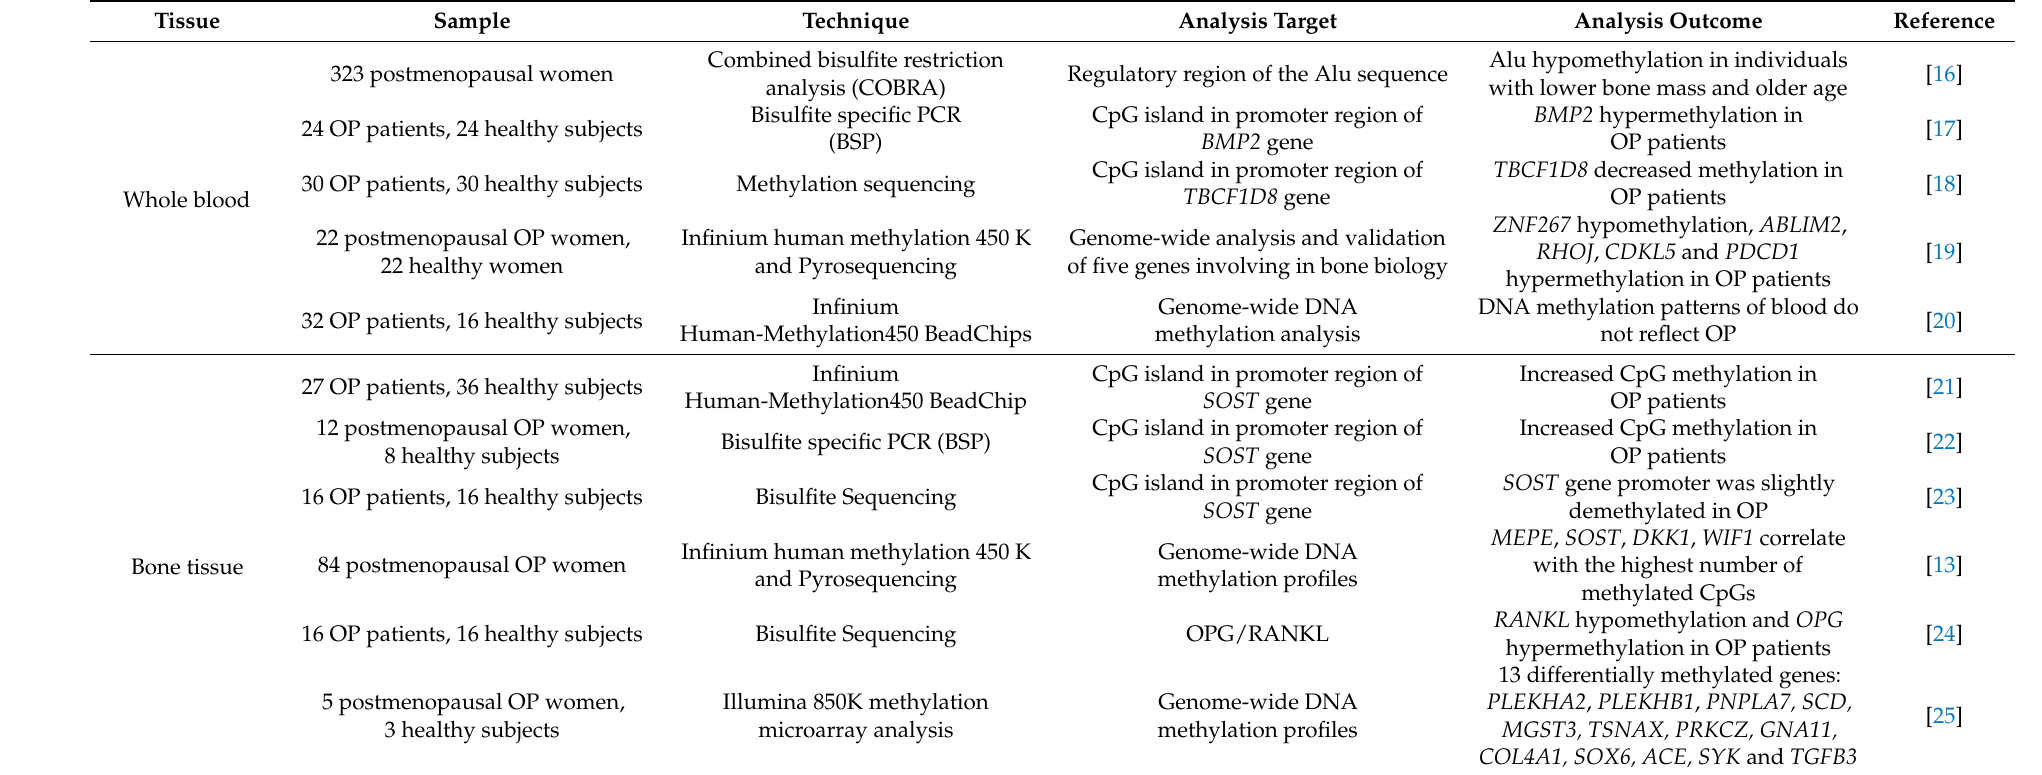
Table 1. Summary of DNA Methylation Studies in